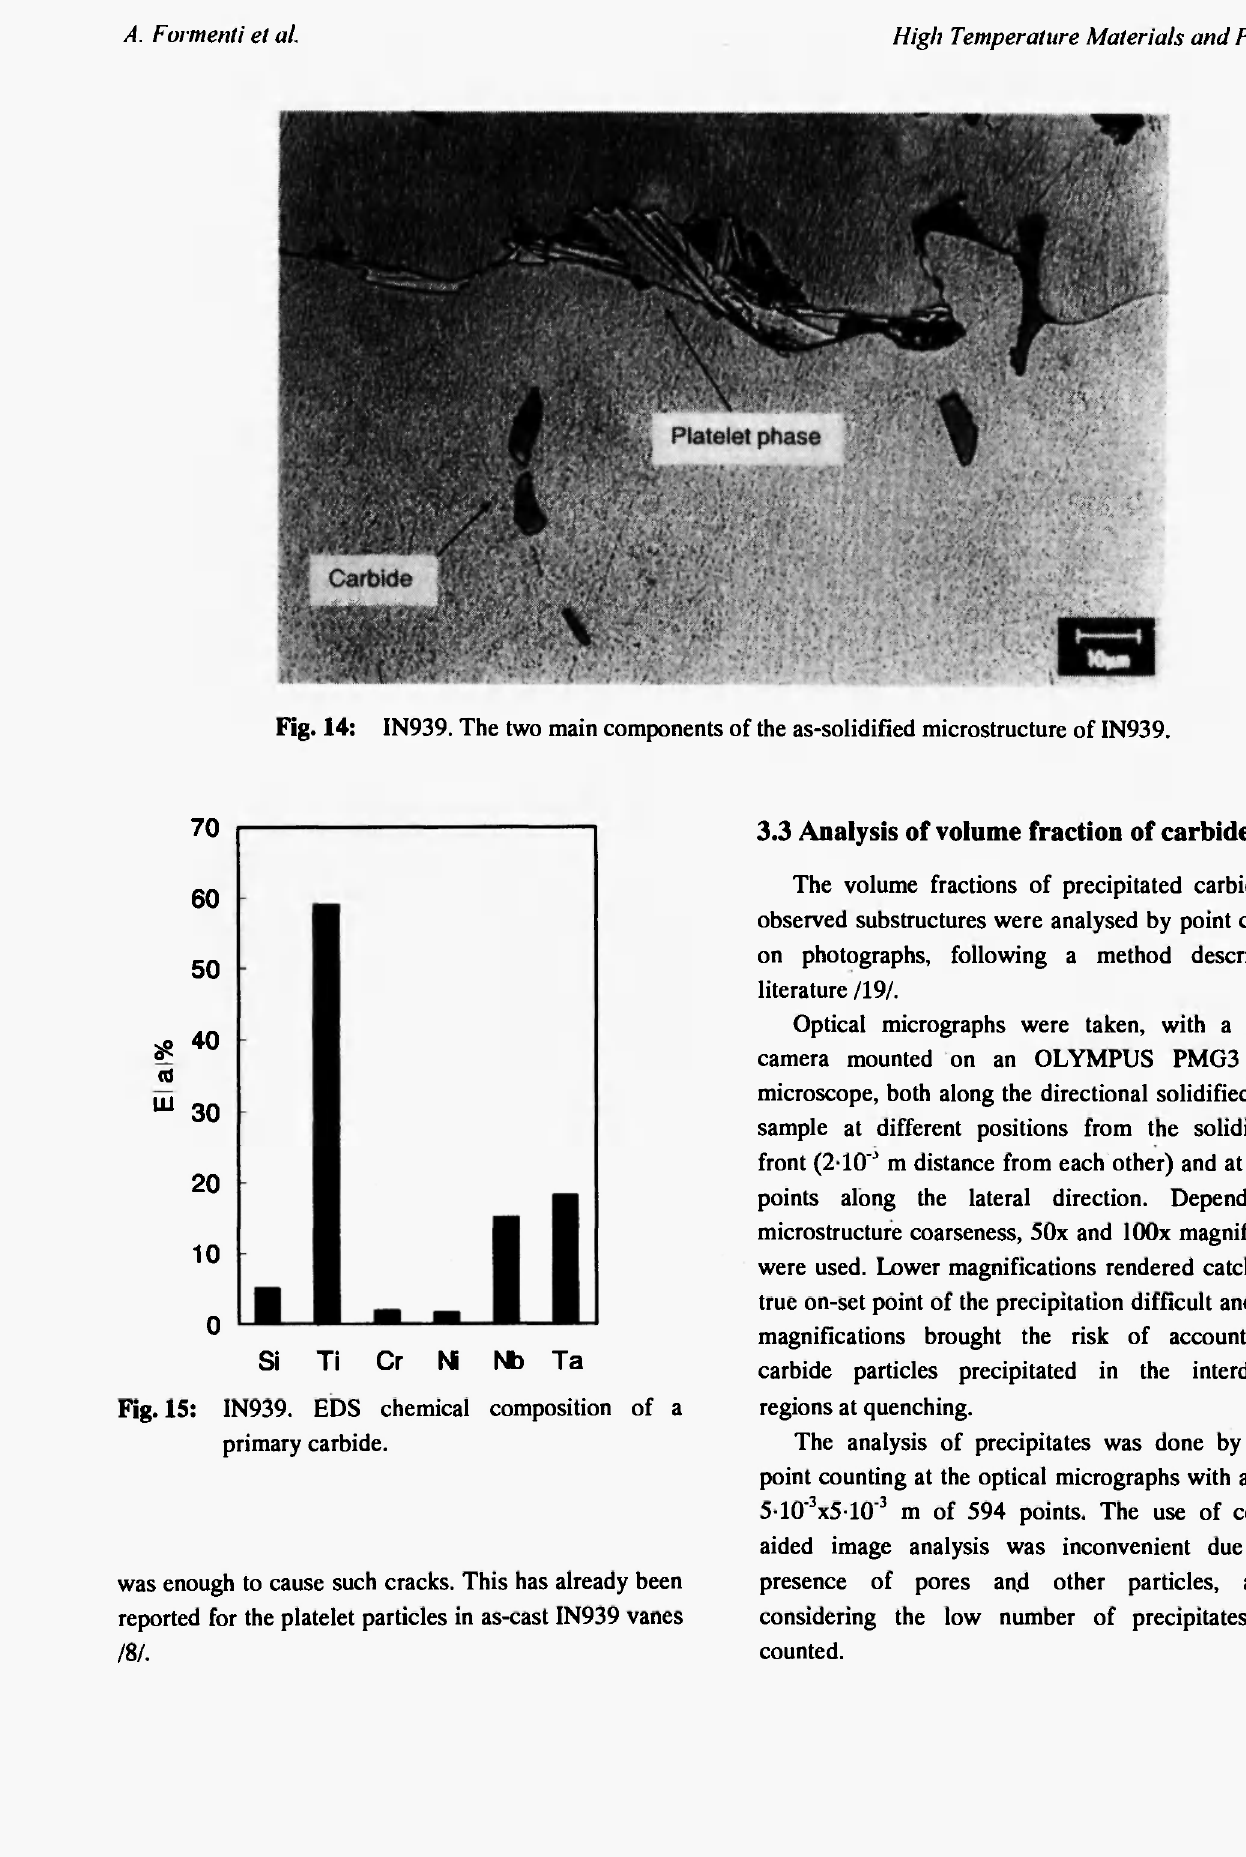
was enough to cause such cracks. This has already been reported for the platelet particles in as-cast IN939 vanes